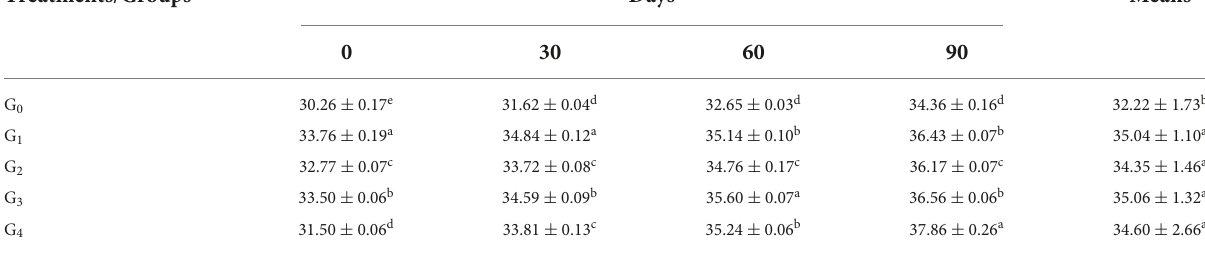
TABLE 4 Effect of fortified diets on hematocrit levels (%) among anemic women.